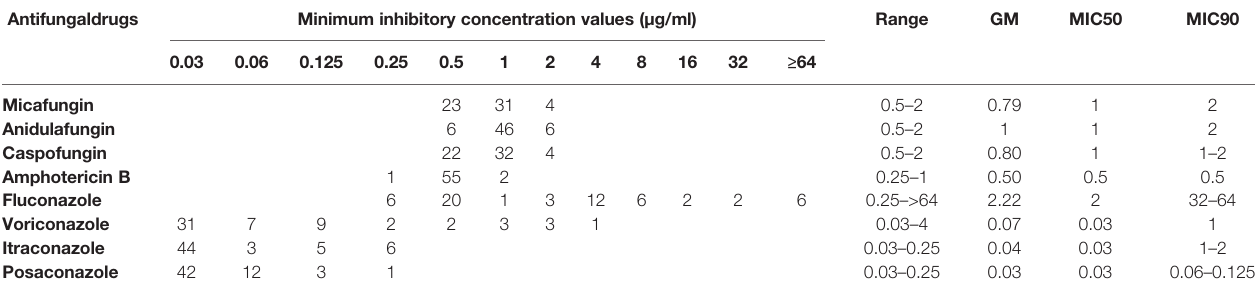
TABLE 2 | Antifungal susceptibility data for Candida parapsilosis blood isolates collected from Ege University Hospital, Turkey, 2019 – 2020.